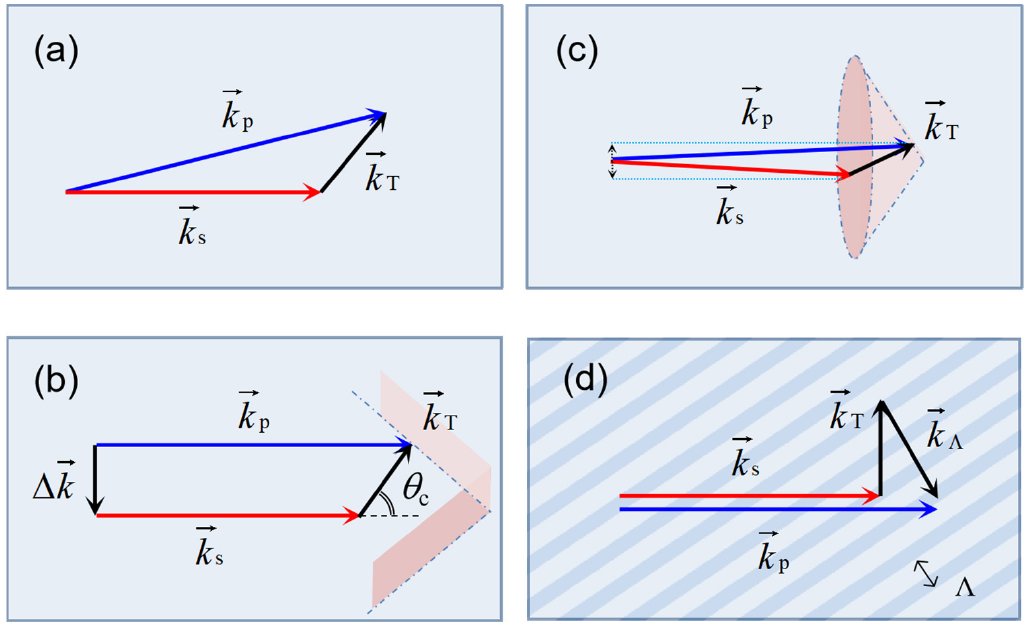
Figure 4. k -vector diagrams of different types of vector PM: ( a ) macroscopic noncollinear PM, ( b ) Cherenkov-type PM, ( c ) PM pumped by Bessel beam, and ( d ) surface-emitted QPM with slant- stripe-type poling period.